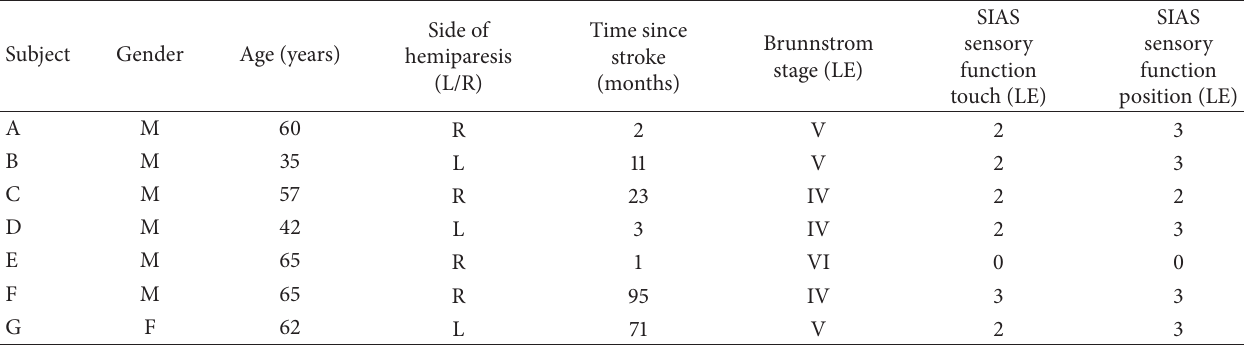
Table 1: Characteristics of subjects with